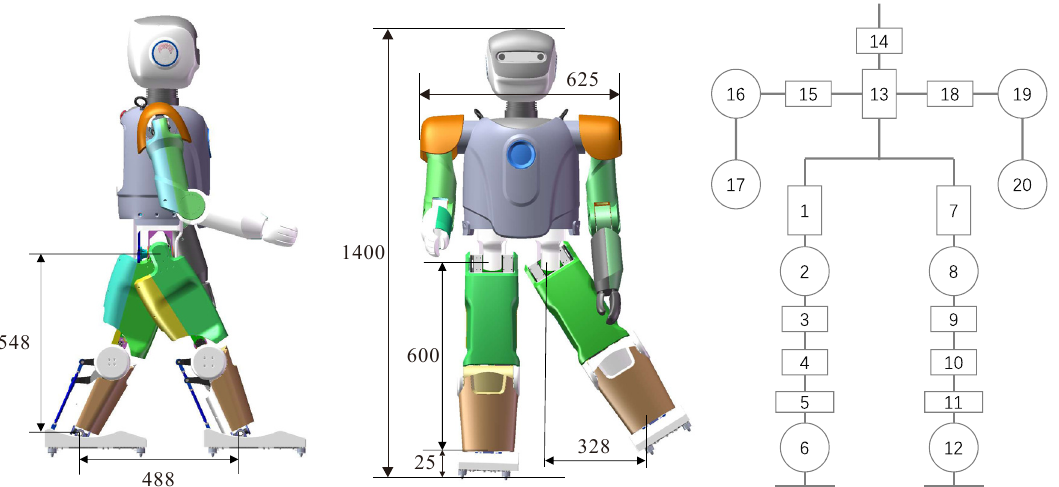
Figure 2. Configuration of the biped robot AIRO built in Zhejiang Lab.